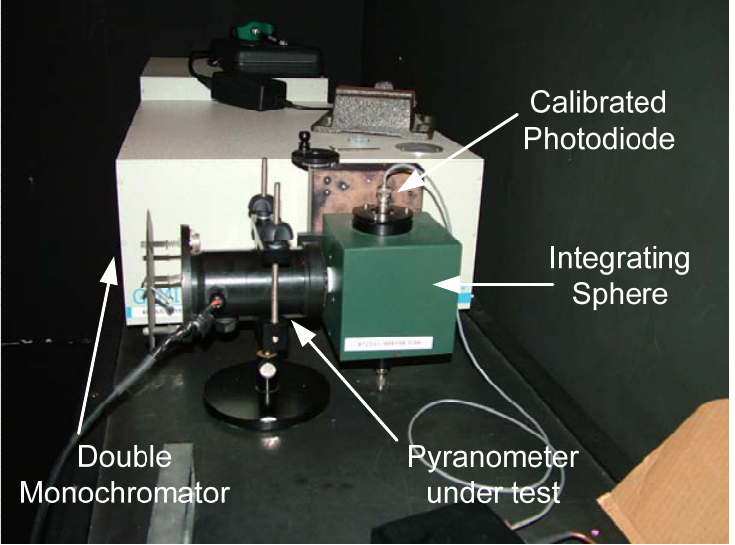
Figure 11. Photograph of the test carried out to determine the RSR (Relative Spectral Response) in the INTA (the Spanish Institute of Aerospace Technology) calibration laboratory in Huelva (Spain).